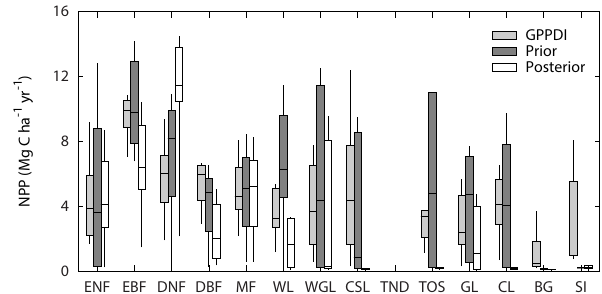
Figure 5. Comparison of AGB (MgCha − 1 ) values for each biome according to IIASA (light grey box) and VISIT with prior (dark grey box) and posterior (open box) parameters. The box-and-whisker plots show the median, upper, and lower quartiles, and the upper and lower 10% of the data.